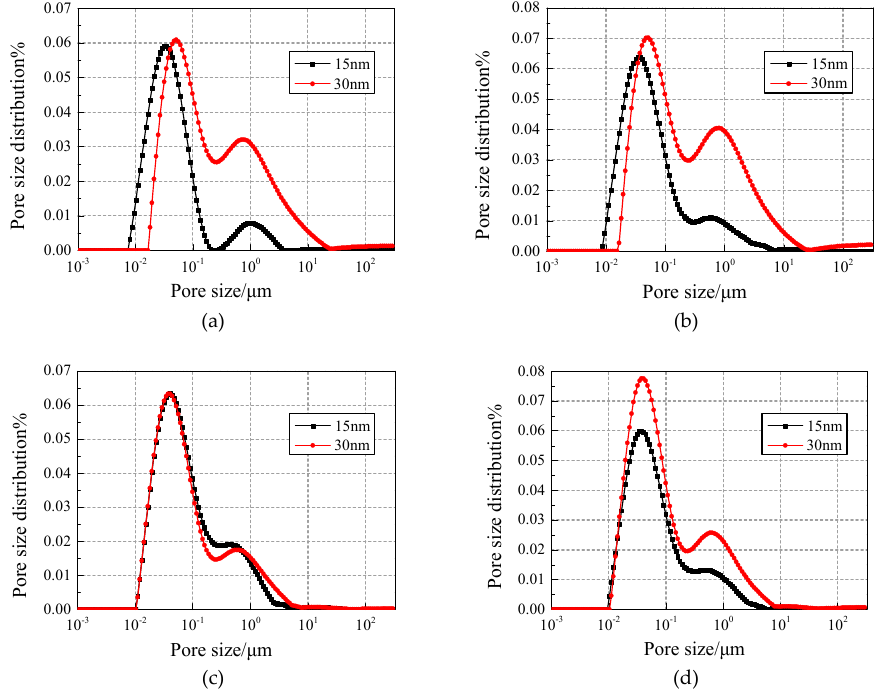
Figure 9. Pore fluid size distribution of NS specimens with different contents under 50 freezing and thawing cycles. ( a ) Content of 0.2%; ( b ) Content of 0.4%; ( c ) Content of 0.6%; ( d ) Content of 0.8%.